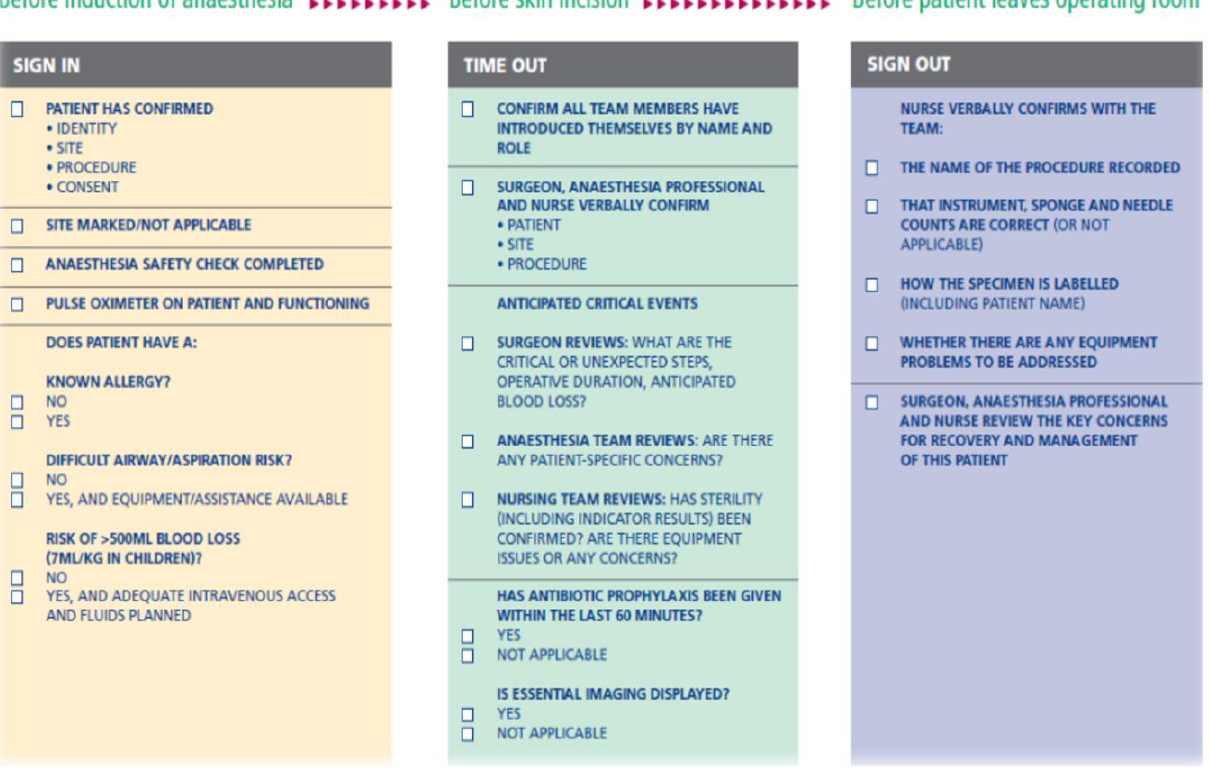
Figure 1: Checklist: Safe surgery campaign. WHO: Information before anesthetic induction, pause before skin incision and before the patient leaves the Operating Room. Available in: